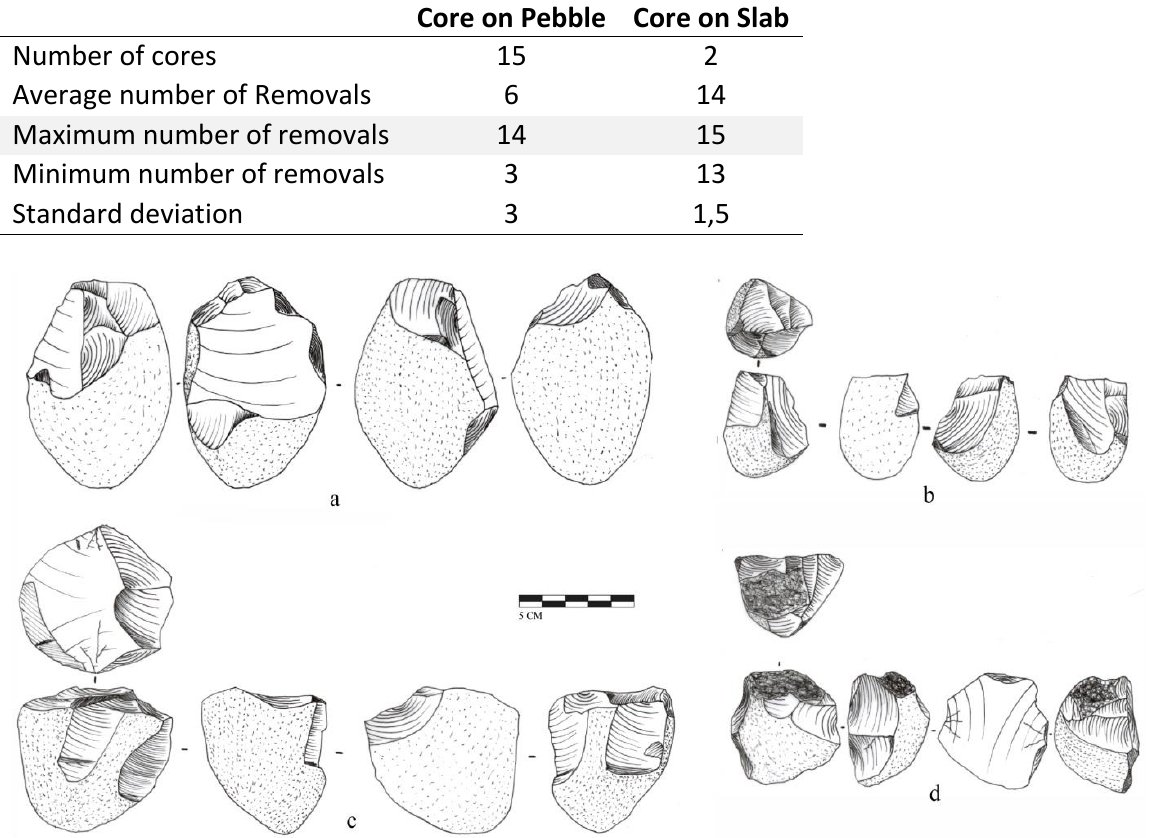
Table 4. Number of removals per core (Tested pebble and indeterminate excluded).